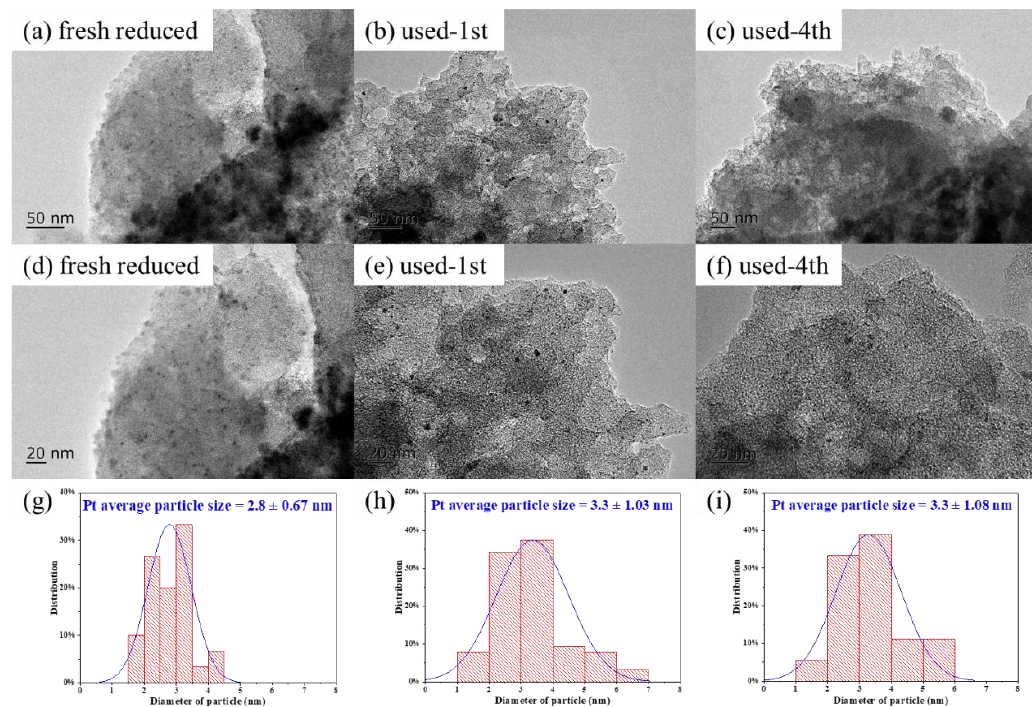
Figure 9. TEM images of freshly-reduced ( a , d ), first-use ( b , e ) and fourth-use ( c , f ) 0.5% Pt-2% FeO x /AC; particle size distribution histogram of freshly-reduced ( g ), first-use ( h ) and fourth-use ( i ) 0.5% Pt-2% FeO x /AC.